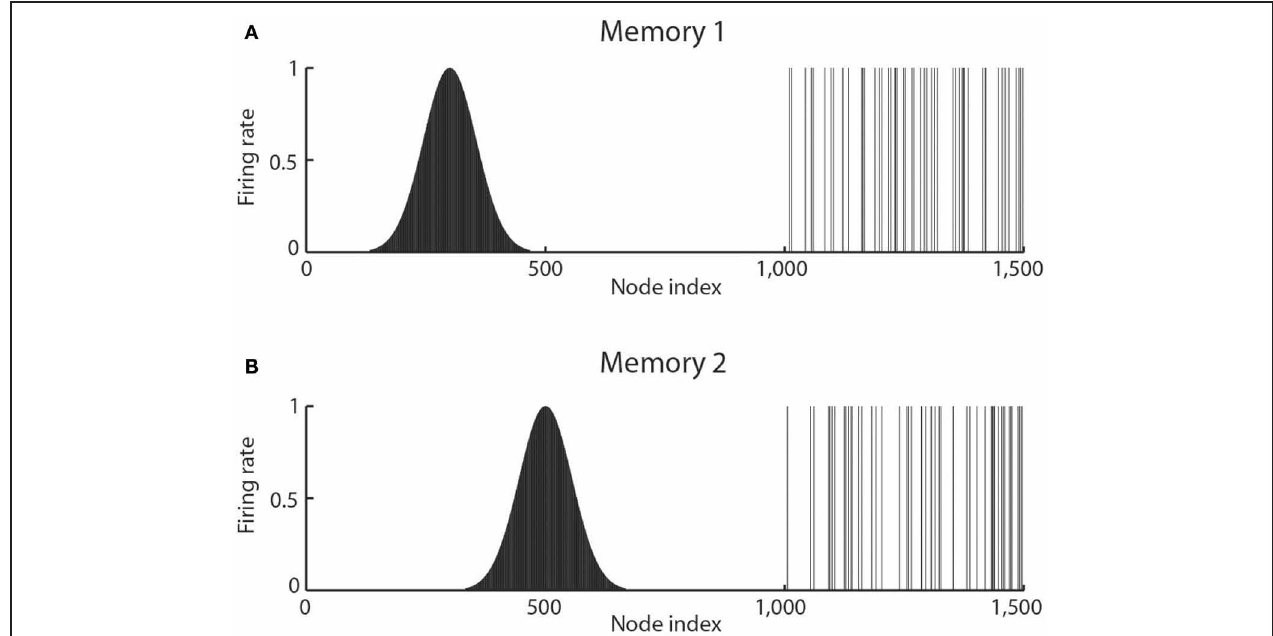
FIGURE 4 | The types of firing patterns stored in continuous attractor networks are illustrated for the patterns present on neurons 1–1000 for Memory 1 (when the firing is that produced when the spatial state represented is that for location 300), and for Memory 2 (when the firing is that produced when the spatial state represented is that for location 500). The continuous nature of the spatial representation results from the fact that each neuron has a Gaussian firing rate that peaks at its optimal location. This particular mixed network also contains discrete representations that consist of discrete subsets of active binary firing rate neurons in the range